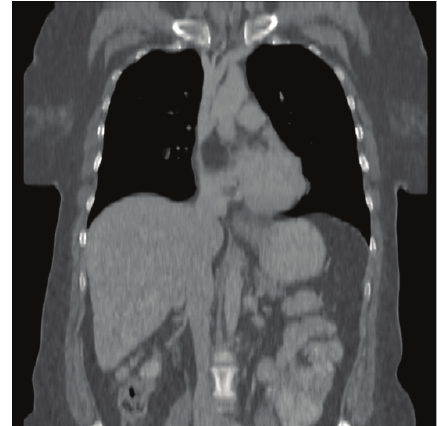
Figure 3: Coronal reconstruction, showing the entire length of the superior vena cava, that is, from the right and left brachiocephalic veins down to the right atrium. Compression by the septal lipoma is seen, at the point where the SVC enters the atrium.